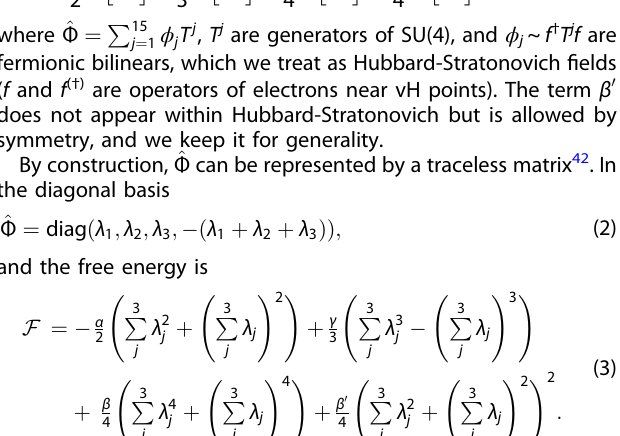
and the ± sign is